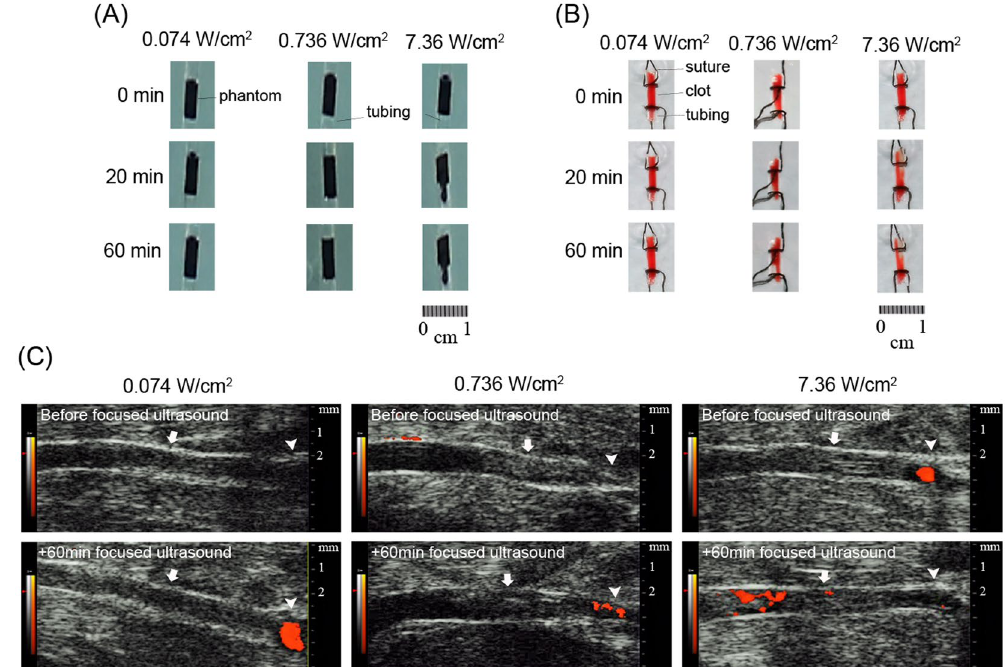
Figure 1. Preliminary study of lysis effect induced by focused ultrasound (FUS) in ( A ) in vitro phantom lysis, ( B ) ex vivo clot lysis, and ( C ) in vivo study under various FUS exposure conditions. In vitro ( A ) and ex vivo ( B ) lysis tests show noticeable lysis while intermediate or high intensity level is employed (0.736 or 7.36 W/cm 2 ). Nevertheless, FUS exposure at any exposure condition cannot effectively induce thrombolytic effect in in vivo ( C ) study. In ( C ), arrowhead indicates carotid bifurcation, and arrow indicates thrombotic portion of common carotid